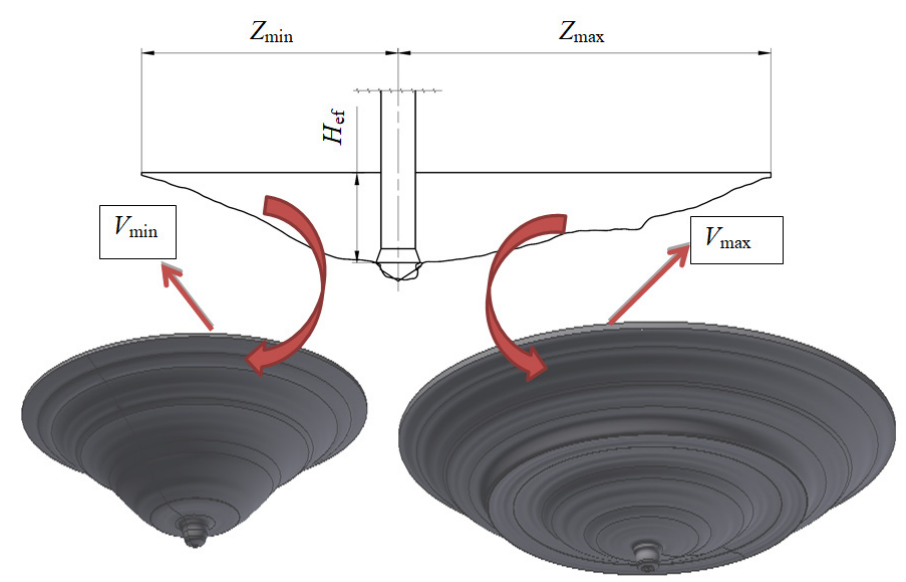
Figure 17: Schematic presentation of the procedure for determination of loosened rocks’ surface area and